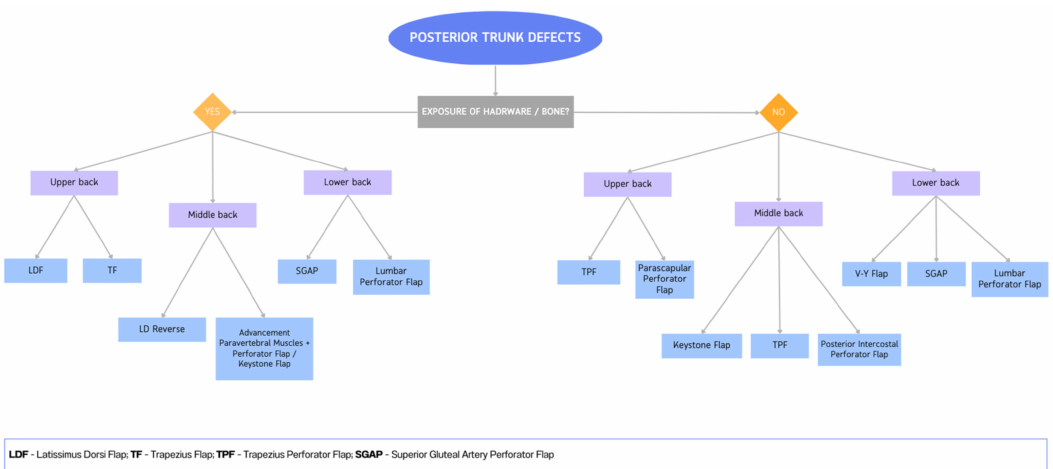
Figure 12. Flowchart for posterior trunk defects